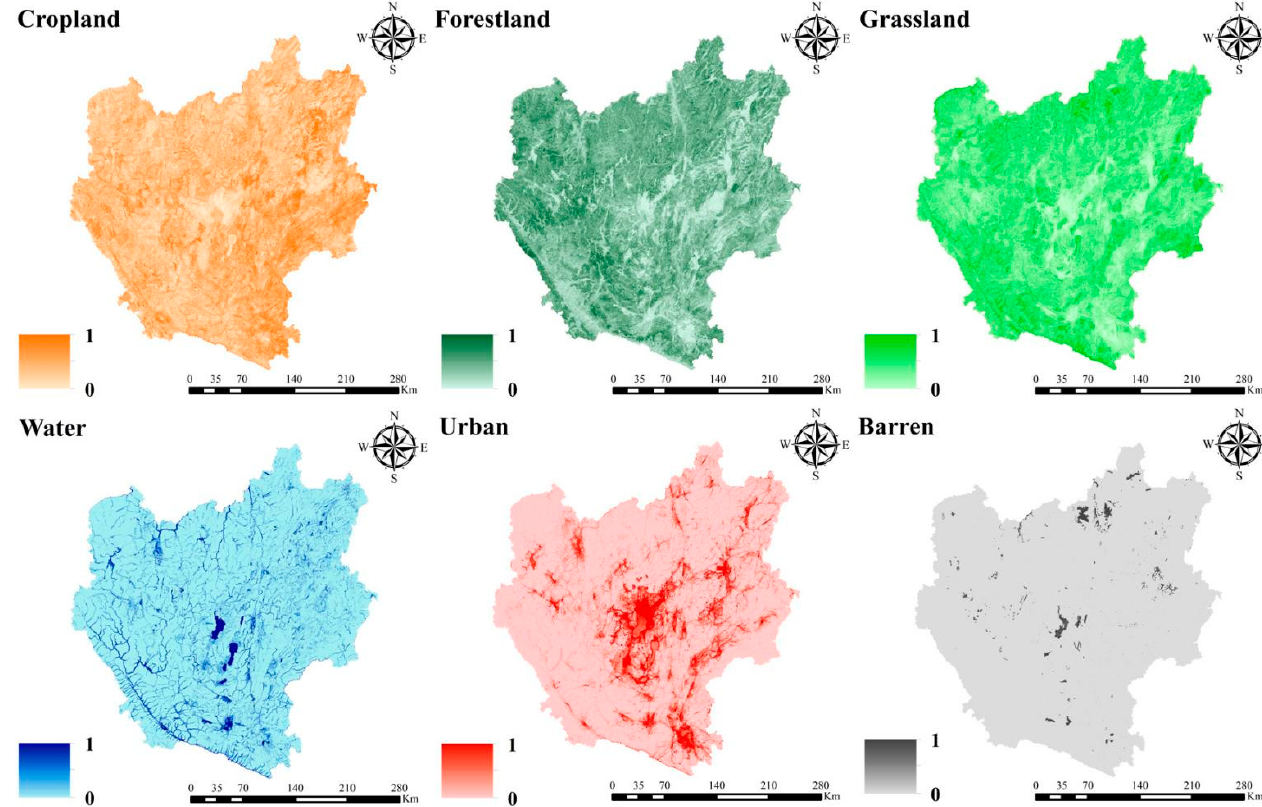
Figure 3. Different kinds of spread distribution.